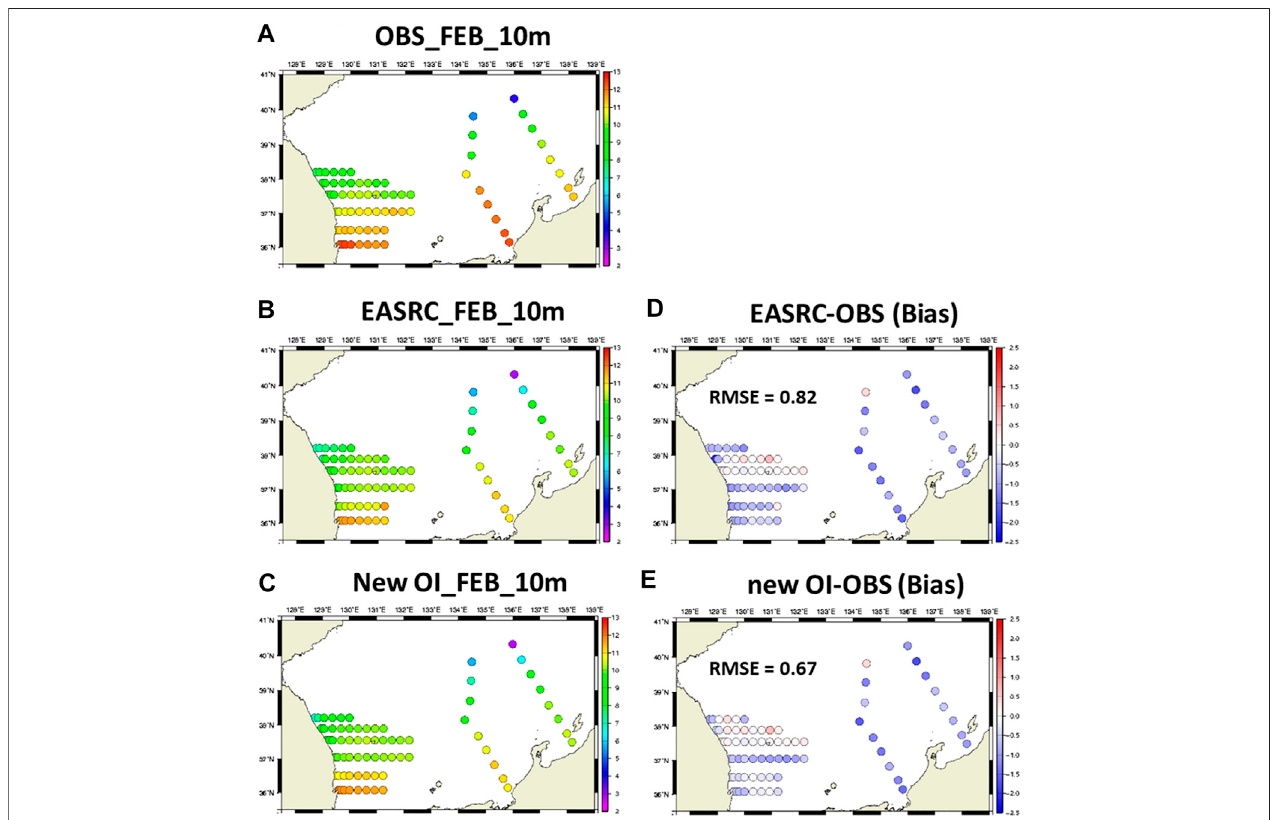
FIGURE9 | Spatial distribution oftemperature and the biaswithrespect toserial observation at 10 m depth in February. [ (A) Observation, (B) EASRC, (C) new OI, (D) EASRC-OBS, (E) new OI-OBS].